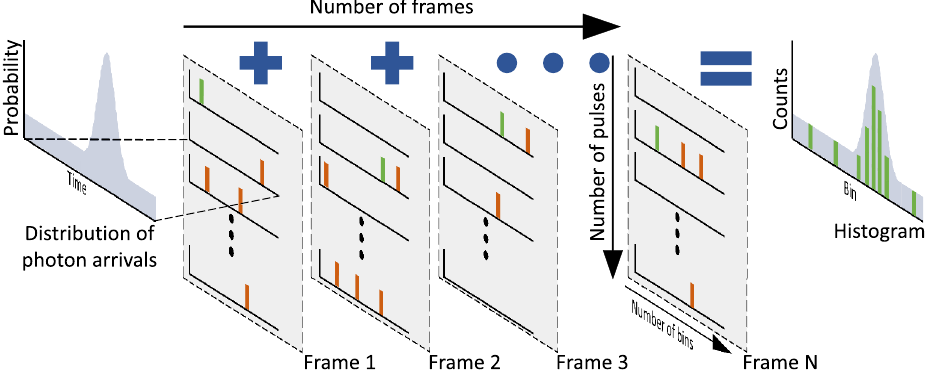
Figure 3. A conceptual illustration of the SPAD histogram simulation process. The salient parameters of the SPAD imaging system (Fig. 1) are used to define a probabilistic distribution of photon arrivals. Next, a data structure with a dimensionality corresponding to the number of bins b , the number of laser pulses ην , and the desired number of frames N is populated by a Binomial sampling procedure based on Eq. (7). The index of the first non-zero value (green bars) on a per-frame basis is then recorded with subsequent non-zero values (orange bars) ignored precisely simulating the ‘first-photon behaviour’ of the SPAD. The first non-zero values can then be accumulated over multiple frames to reconstruct a histogram with a distribution matching that of Eq. (7).